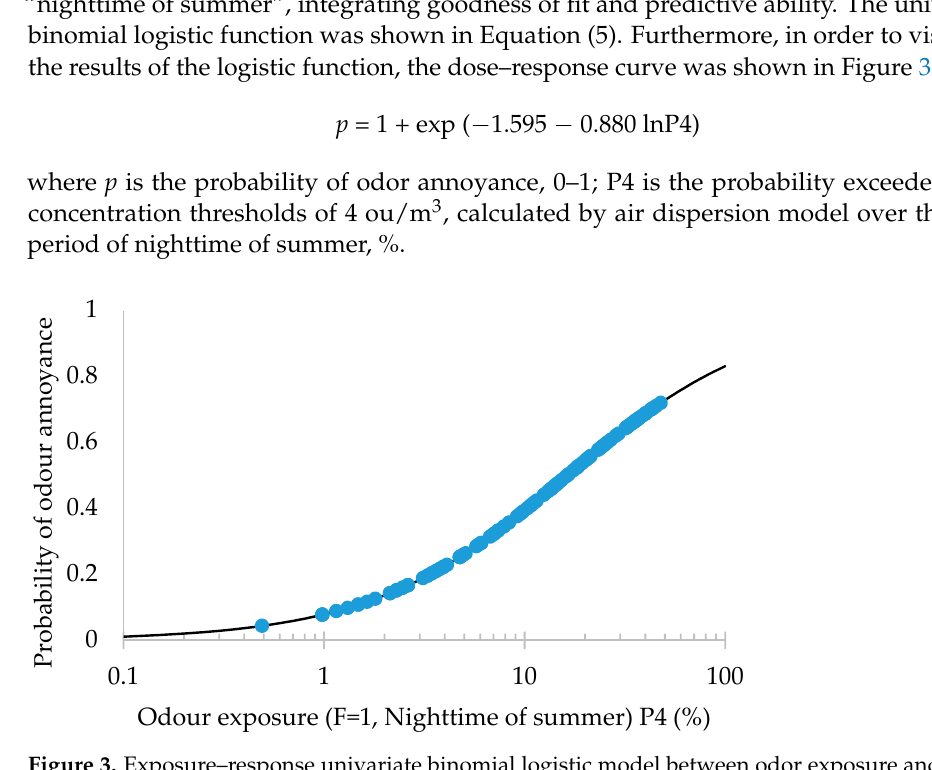
Figure 3. Exposure–response univariate binomial logistic model between odor exposure and probability of odor annoyance; The odor exposure of P4 is the probability exceeded odor concentration thresholds of 4 ou/m 3 , calculated by air dispersion model over the time period of nighttime of summer, %; F: Peak-to-mean factor.